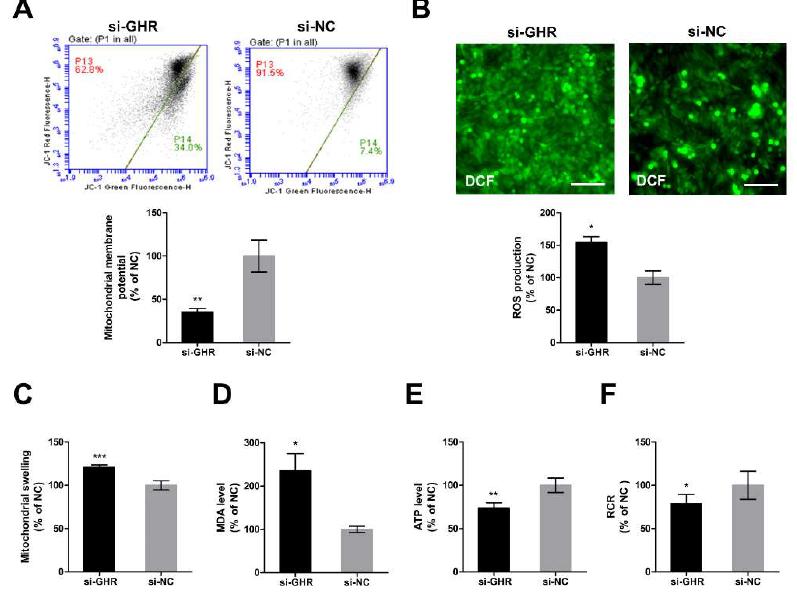
Figure 6. Knockdown of GHR caused mitochondrial dysfunction in DF-1 cells. ( A ) Mitochondrial ∆Ψ m was measured by the fluorescence of JC-1 at 48 h after transfection with si-GHR and si-NC fragments in DF-1 cells. Red fluorescence represents aggregation of JC-1, green fluorescence represents monomeric JC-1, ∆Ψ m was represented as the ratio of aggregated and monomeric JC-1. ( B ) Reactive oxygen species production was measured by the fluorescence of DCF at 48 h after transfection with si-GHR and si-NC fragments in DF-1 cells. Bar, 100 µ m. ( C ) Mitochondrial swelling was measured by the absorbance at 540 nm after transfection with si-GHR and si-NC fragments in DF-1 cells. The level of ( D ) MDA and ( E ) ATP were measured at 48 h after transfection with si-GHR and si-NC fragments in DF-1 cells. ( F ) Respiratory control ratio was calculated as the ratio of state III to state IV respiration rate at 48 h after transfection with si-GHR and si-NC fragments in DF-1 cells. Data are expressed as means ± SEM, * p < 0.05; ** p < 0.01; *** p < 0.001.